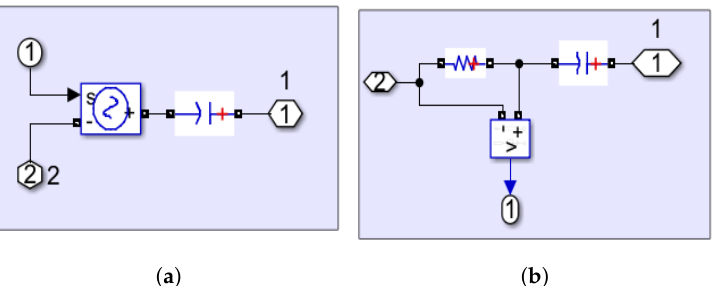
Figure 7. Capacitive ( a ) coupling and ( b ) decoupling networks implemented in